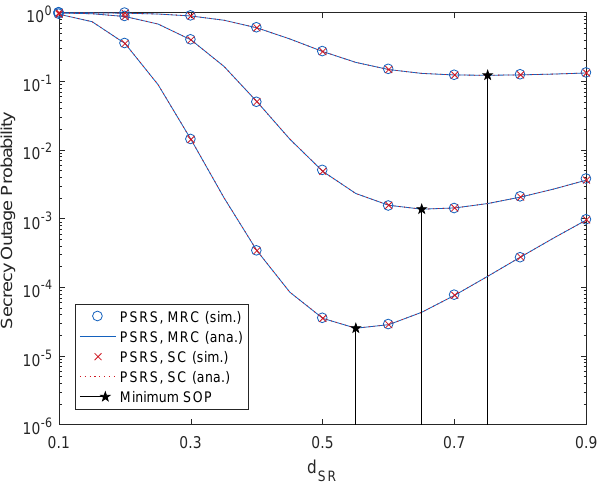
Figure 4. Secrecy outage probability as a function of the source relay distance, d SR , with different values of the main-to-eavesdropper ratio (MER), where M = 3, N = 3, SNR = 20 dB and R th = 2 bits/s/Hz.